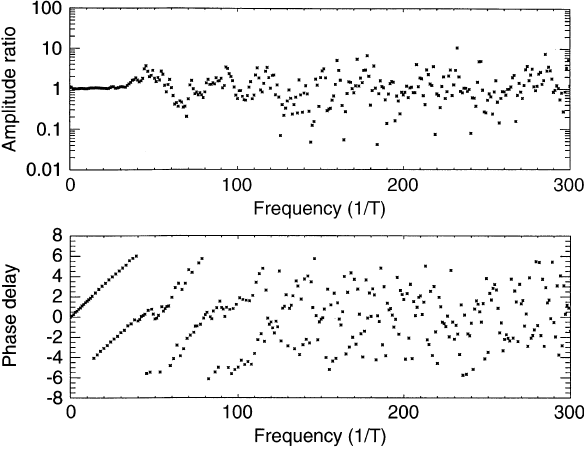
Fig. 9. The amplitude ratio and the phase di(cid:128)erence of the time evolving, Hanning windowed datasets. The abscissas denote the frequency in units of D f , the ordinate of the upper plot the amplitude ratio and of the lower plot the phase di(cid:128)erence. The zero frequency and frequencies higher than 300 D f are